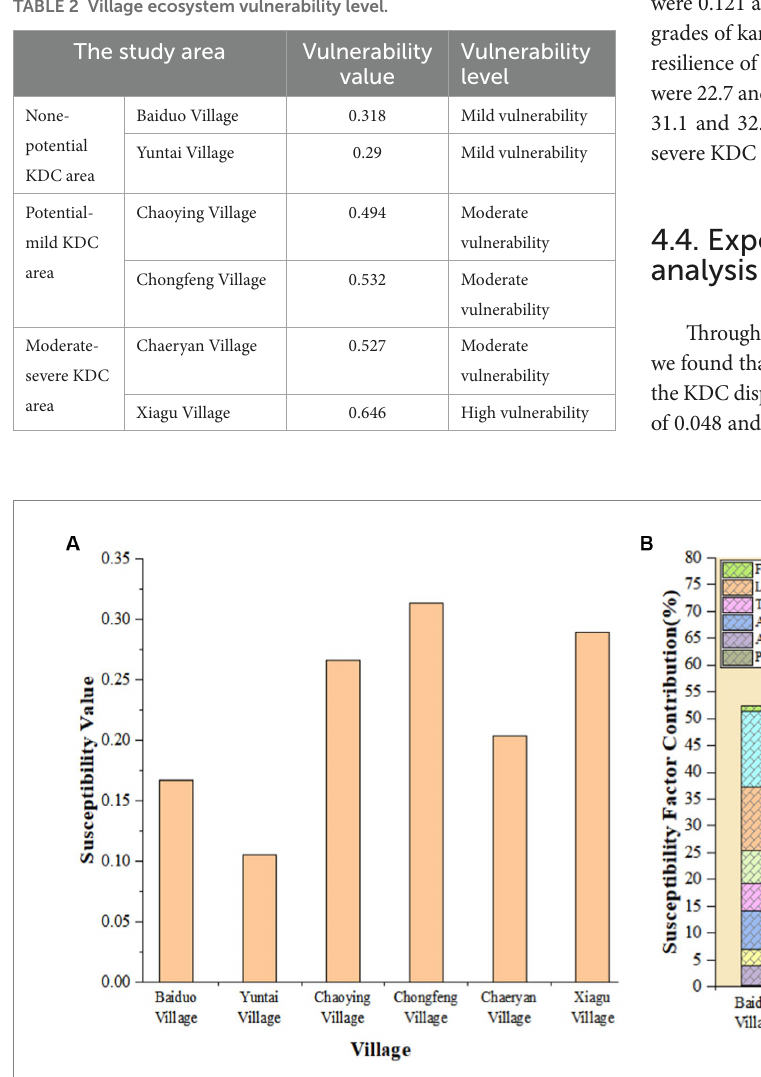
FIGURE 2 Susceptibility analysis of villages ecosystem in the KDC. (A) susceptibility values. (B) Contribution of susceptibility factor.